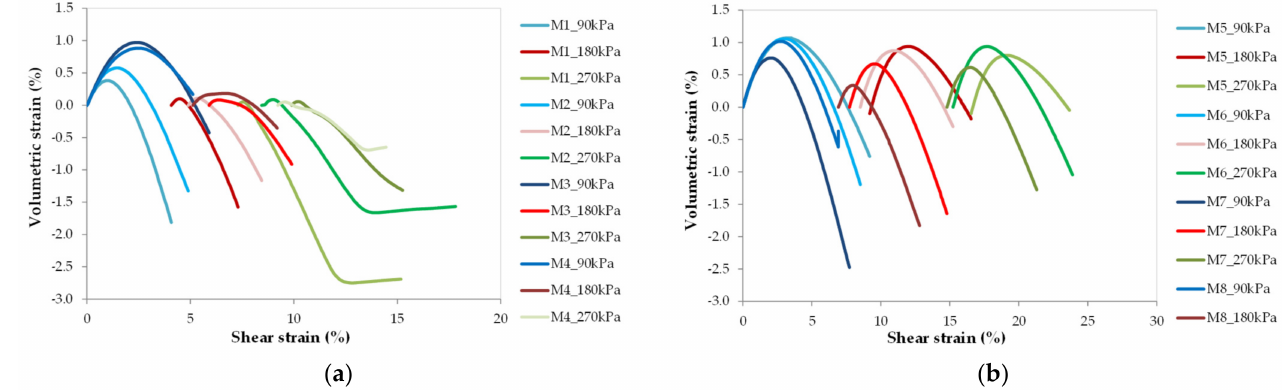
Figure 9. Typical plot for variation of volumetric strain with shear strain for RCA and RCA–RTW mixtures. ( a ) RCA mixtures: M1, M2, M3, and M4; ( b ) RCA–RTW mixtures: M5, M6, M7,